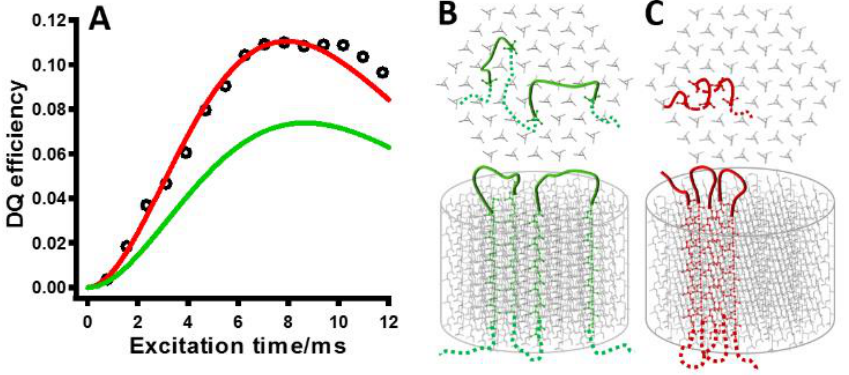
Figure 11. ( A ) 13 C – 13 C DQ buildup curve for 15 wt% 13 C CH 3 enriched i PP mesomorphic blends with